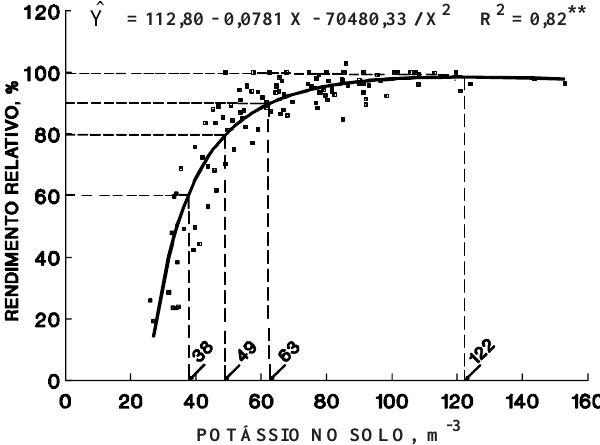
Figura 1. Rendimento relativo de soja em função do teor de potássio disponível no solo. Resultado de doze safras. Média de três